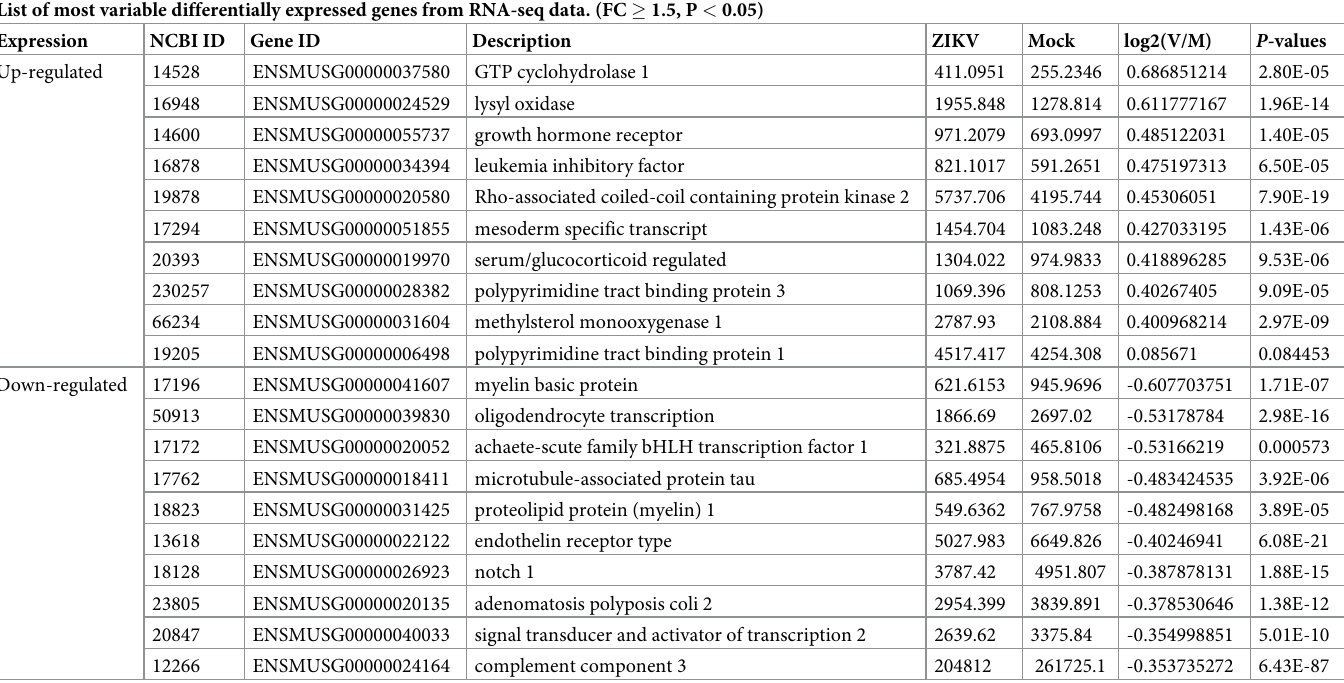
Table 2. The enrichment of top 10 genes in ZIKV infected MPAs. List of most variable differentially expressed genes from RNA-seq data. (FC � 1.5, P <